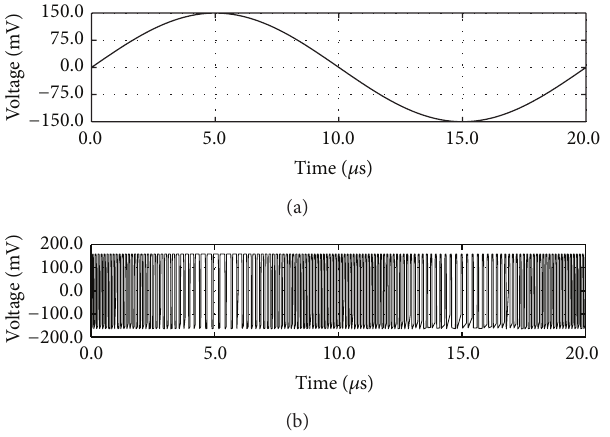
Figure 23: Sinusoidal modulating signal and (b) sigma delta modulated